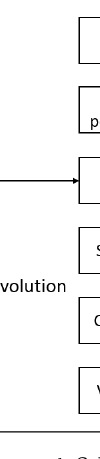
Figure 4. Schematic diagram of the genetic algorithm work-flowchart.